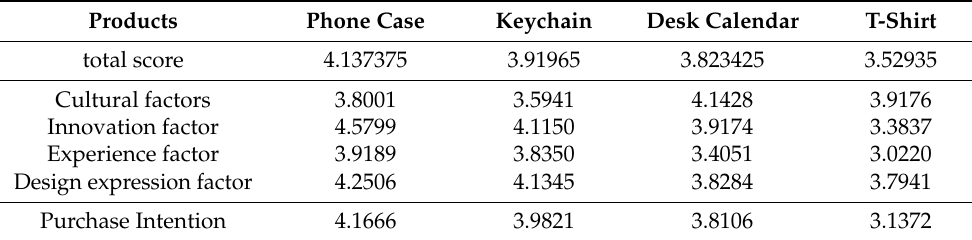
Table 4. Four products